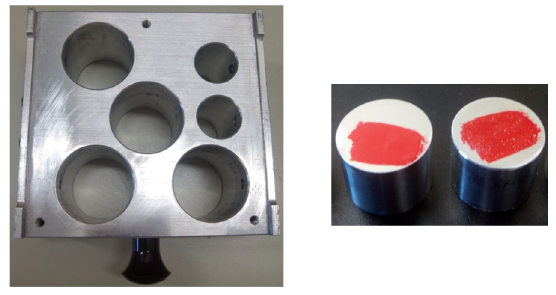
Figure 1. Holder and aluminum stubs with the sample over the red glue.